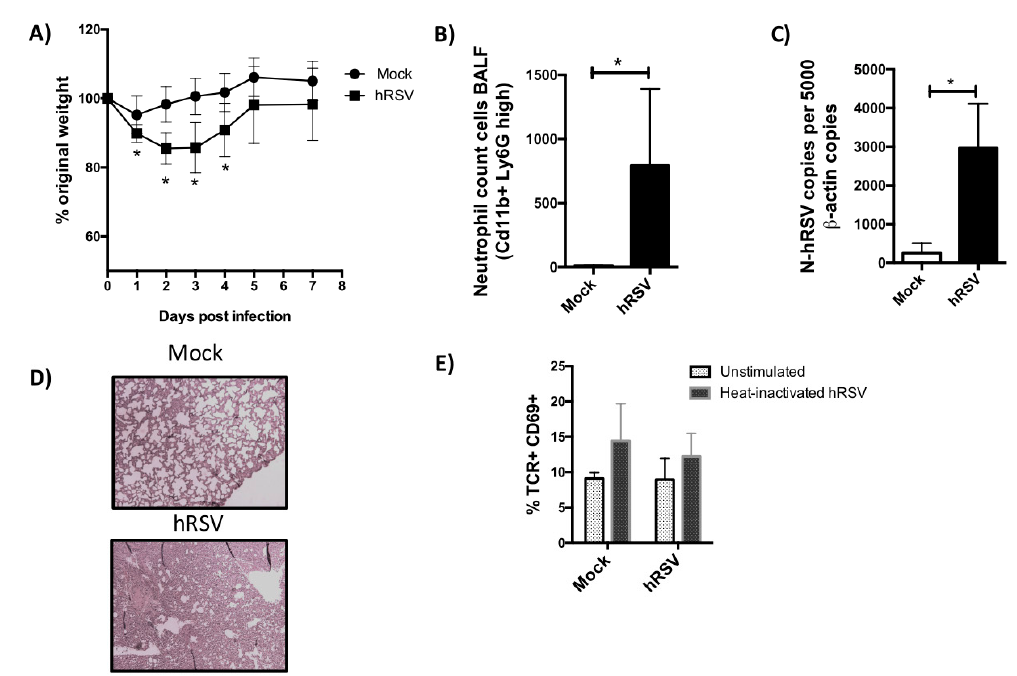
Figure 1. T cell expansion induced by human respiratory syncytial virus (hRSV) infection. BALB/cJ mice were infected with 1 × 10 6 PFU of hRSV and 7 days after infection, mice were euthanized. Bodyweight was measured for seven days ( A ). Neutrophils in the BALF were evaluated by FACS ( B ). Lung damage was evaluated by lung histology ( C ). Viral loads were evaluated by RT-qPCR ( D ). Lung % TCR + CD69 + cells ( E ). The spleens of mice sacrificed at seventh day post-infection were collected, and the resulting splenocytes were then stimulated with heat-inactivated hRSV (HI-hRSV) (57 °C for 30 min). Seventy-two hours poststimulation the TCR + CD69 + cells as a T cell activation marker were detected by flow cytometry. ( A ) Two-way ANOVA paired test and multiple t -students test were performed to assess statistical differences (* p < 0.05) indicating statistical difference in (i) time and infection condition, (ii) significant decrease of percent original weight in hRSV-infected as compared to mock-treated mice at days 1, 2, 3 and 4 postinfection. ( A , D , E ) t -students tests were performed (* p < 0.05). Bars represent mean ± SD in all graphs.